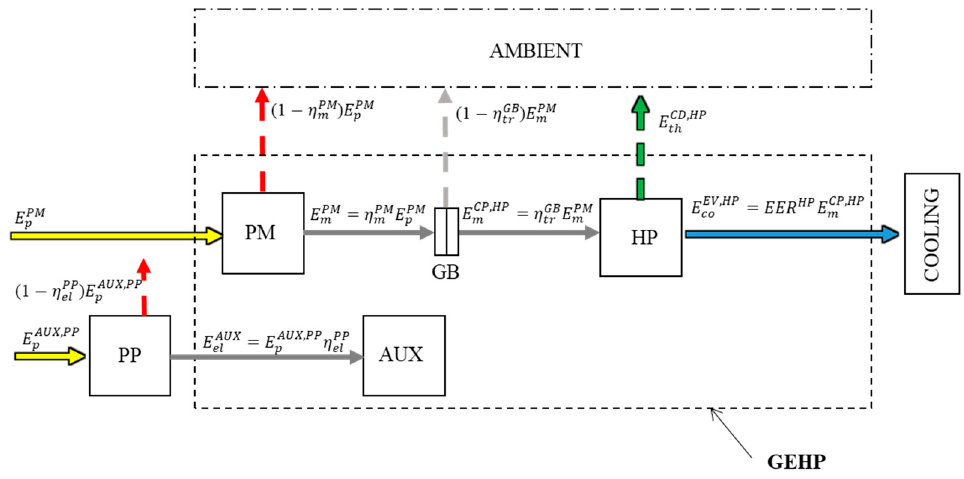
Figure 11. GEHP in cooling mode.